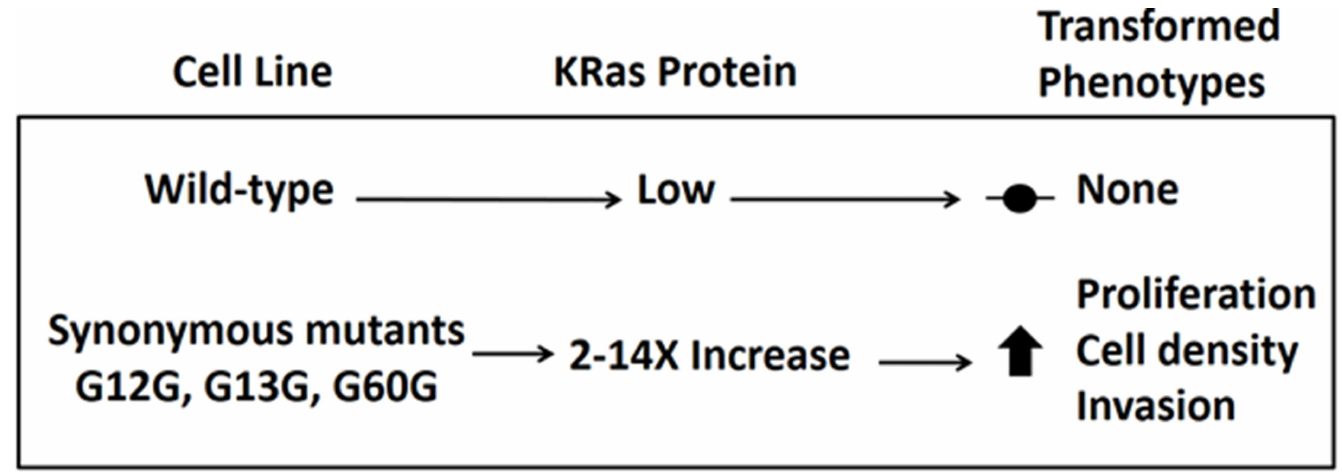
Fig 5. Working model. The WT KRAS nucleotidesequence has been evolutionarily conservedto minimize protein expression, especiallyat G12, G13, and G60. Any synonymous mutation at those positionsleads to overexpression of KRAS protein and subsequent increasesin proliferation, maximum cell density, and invasionin NIH 3 T 3